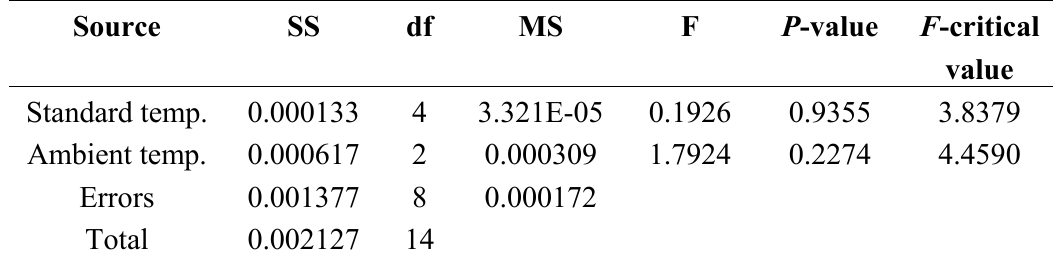
Table 3. Analysis of variance ANOVA table for the effect of standard temperature and